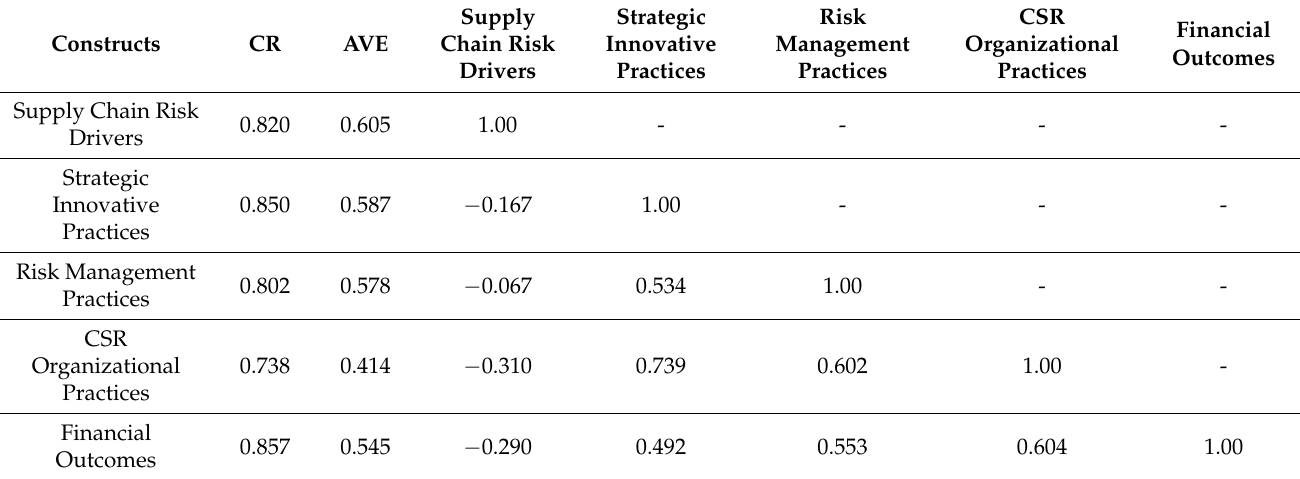
Table 2. Reliabilities and Inter-item